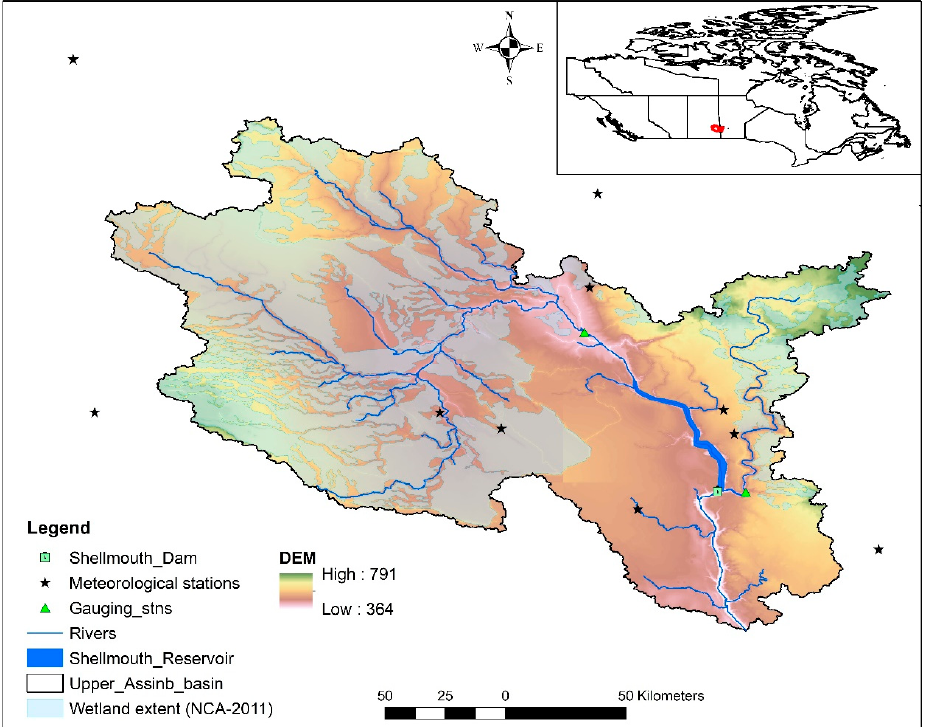
Figure 1. Study area of the Upper Assiniboine River Basin.